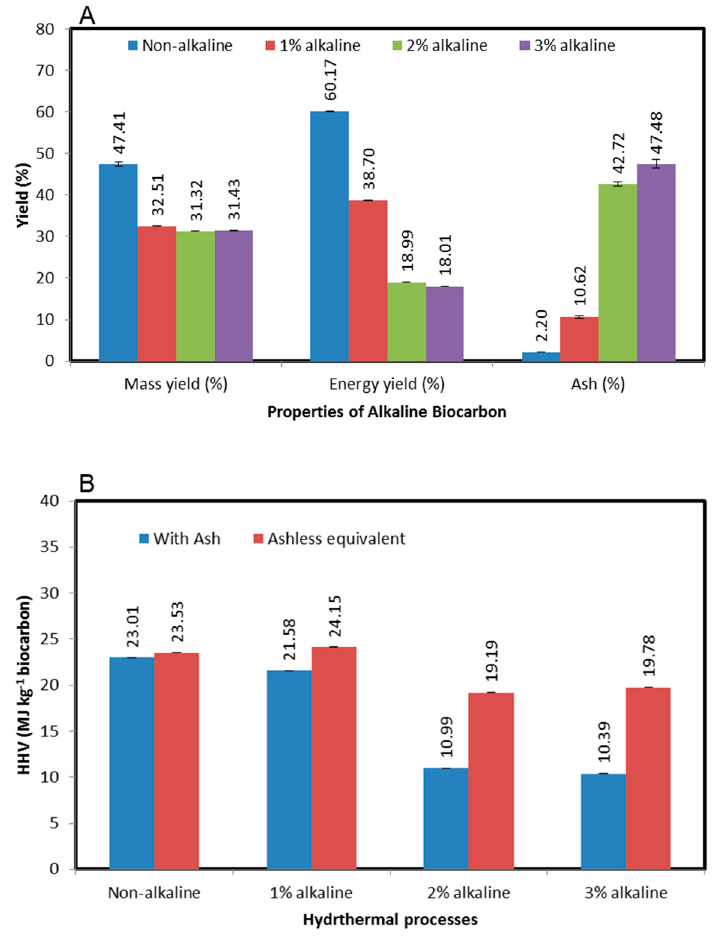
Figure 6. Properties of different alkaline hydrothermal pretreated corn residue biocarbons. ( A ) mass yield, energy yield and ash content; ( B ) higher heating value (HHV).